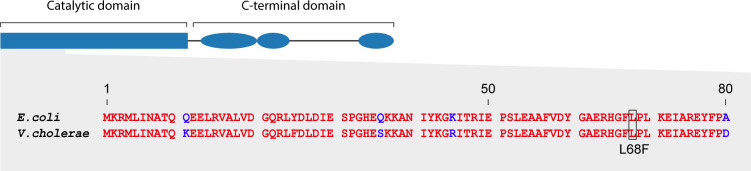
Conservation of RNase E between E. coli and V. cholerae.Sequence alignment of the first 80 N-terminal amino acids of RNase E from E. coli and V. cholerae. The temperature-sensitive rne-3071 mutation changing a leucine to phenylalanine at position 68 is indicated.